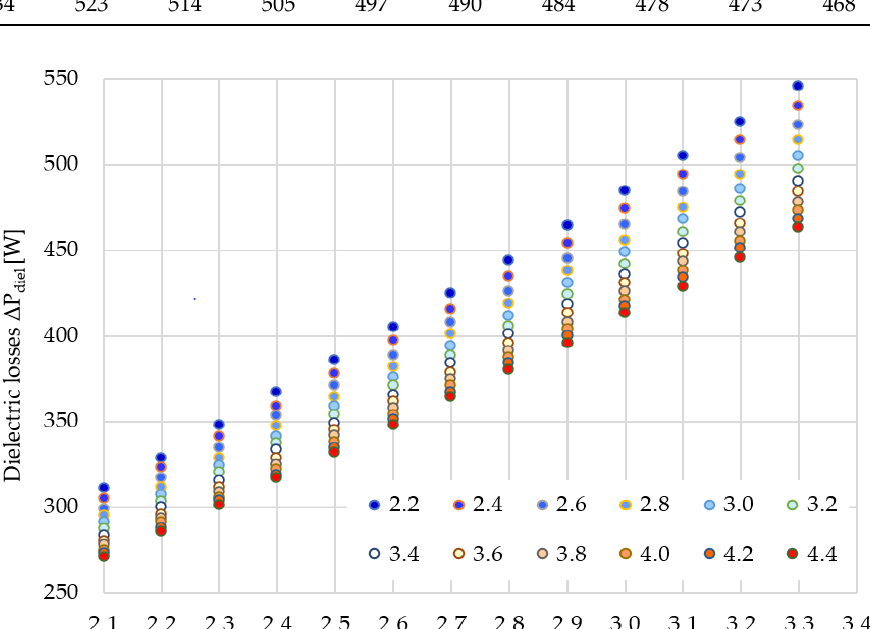
Figure 3. Dielectric losses in the selected transformer depending on the electrical permittivity of used paper and the electrical insulating liquid (legend corresponds to relative electrical permittivity of the paper).